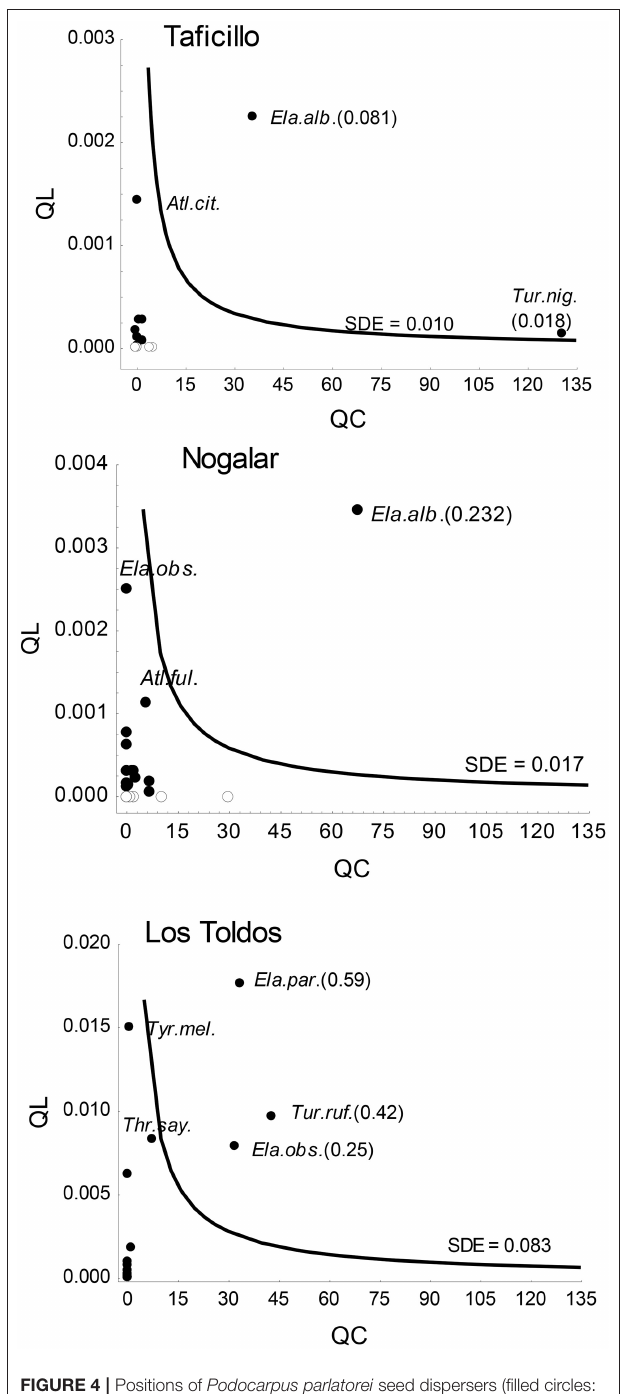
FIGURE 4 | Positions of Podocarpus parlatorei seed dispersers (filled circles: forest edge species; open circles: forest species) on the seed dispersal effectiveness (SDE) landscape in three subtropical Andean cloud-forest sites. Isoclines indicate the mean SDE across all functional groups in each site. The species name and SDE-values between brackets are given only for highly effective seed dispersers; names of moderately effective species with high QL-values are also shown. Acronyms of gulpers are Ela.alb, Elaenia albiceps ; Ela.obs, Elaenia obscura ; Ela.par, Elaenia parvirostris ; Tur.nig, Turdus nigriceps ; Tur.ruf, Turdus rufiventris ; Tyr.mel, Tyrannus melancholicus ; mashers are Atl.cit, Atlapetes citrinellus ; Atl.ful, Atlapetes fulviceps ; Thr.say, Thraupis sayaca